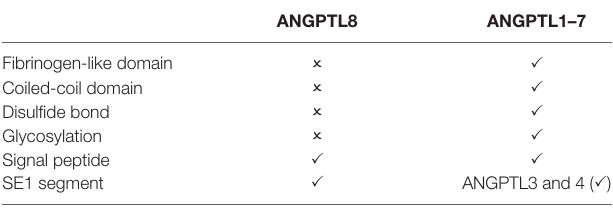
TAbLe 1 | Structure feature of